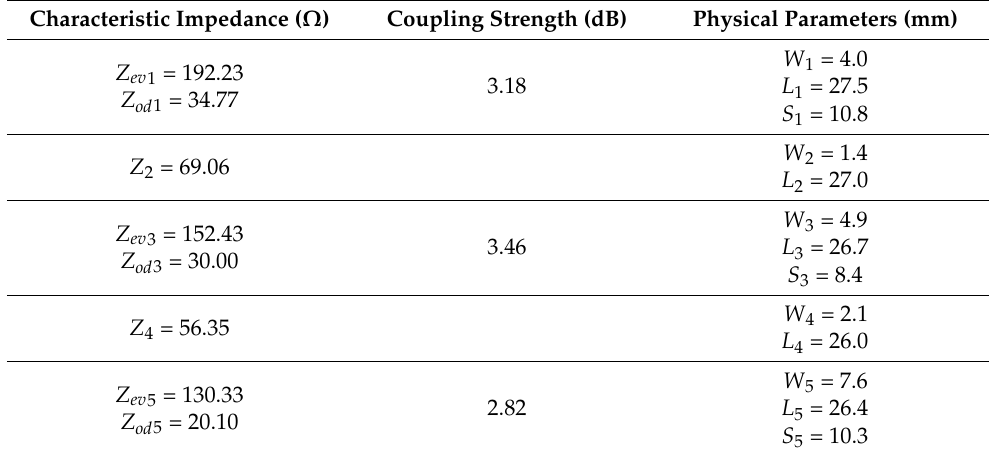
Table 6. Parameters of the fabricated